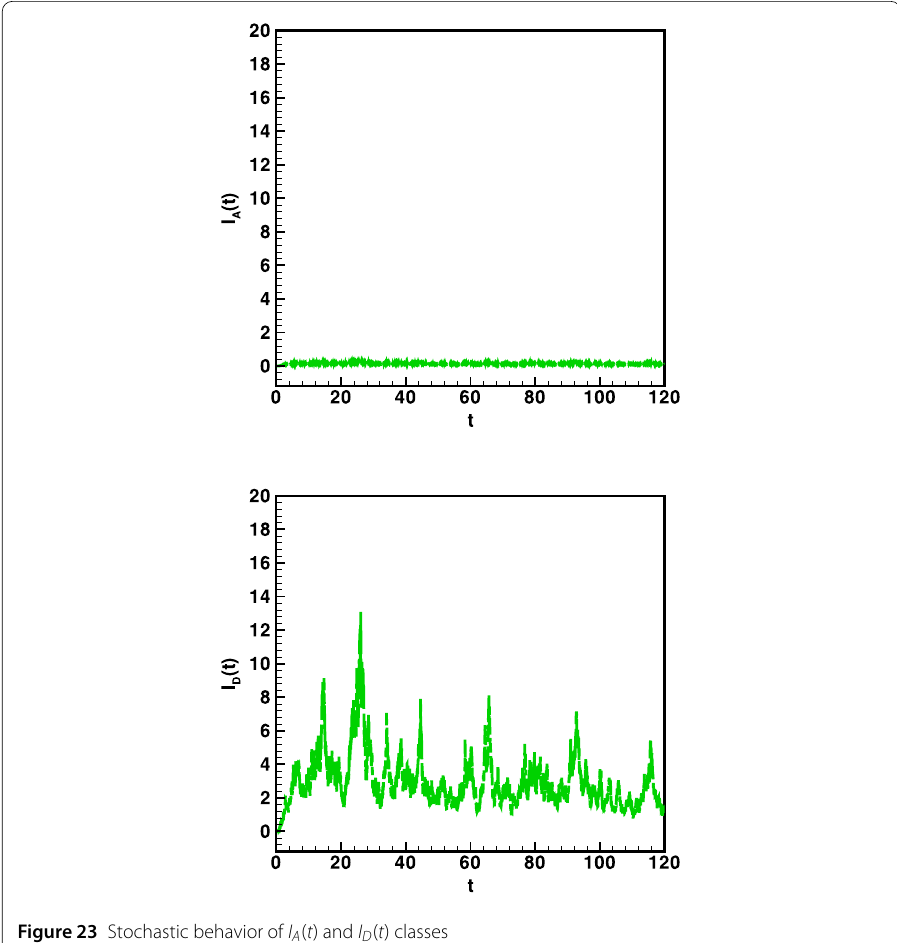
Figure 23 Stochastic behavior of I A ( t ) and I D ( t )